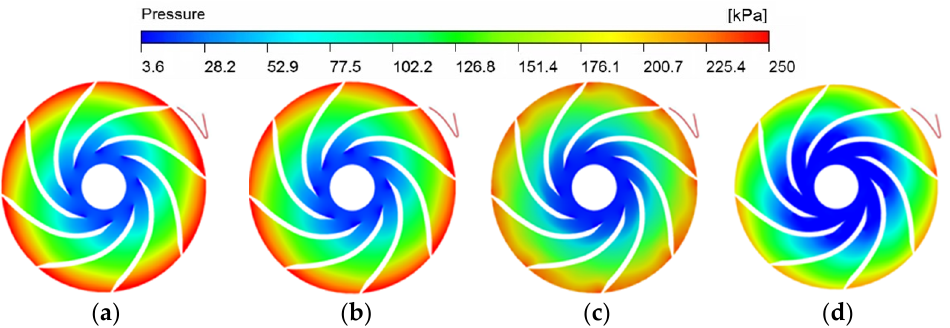
Figure 7. Static pressure distributions on middle cross-section of the impeller of the pump with inducer: ( a ) NPSHa = 1.67 m; ( b ) NPSHa = 1.32 m; ( c ) NPSHa = 1.05 m; ( d ) NPSHa = 0.65 m.